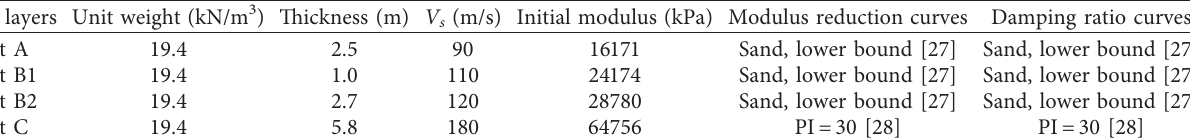
Figure 1: Profile of the wildlife site case after Ching and Glaser [26]. Table 1: Soil parameters used for nonlinear effective analysis.